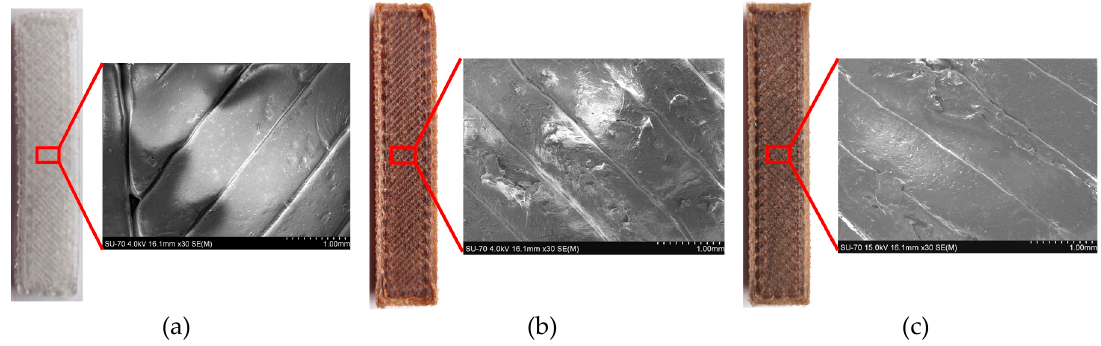
Figure 7. Thermal analyses: thermogram ( a , b ) first derivative of weight loss as a function of the temperature of Cork/PMMA, C- g -PMMA/PMMA and PMMA.